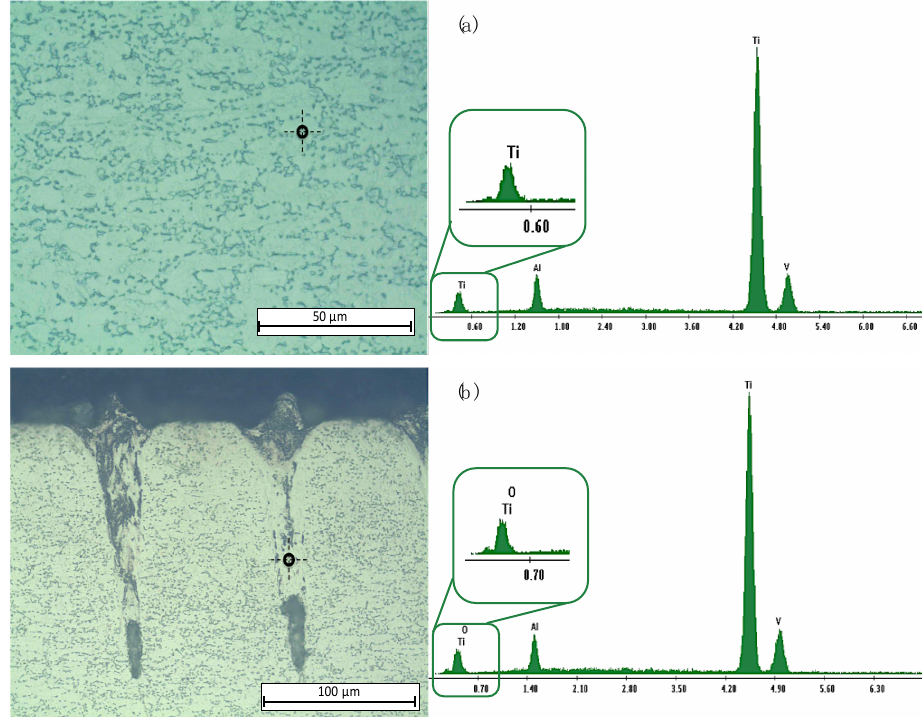
Figure 2. ( a ) Microstructure and EDS analysis of Ti6Al4V surface; ( b ) Cross section and EDS analysis of heat affected zone of laser incidence for 17.68 J/cm 2 ; 10 mm/s texturing conditions.